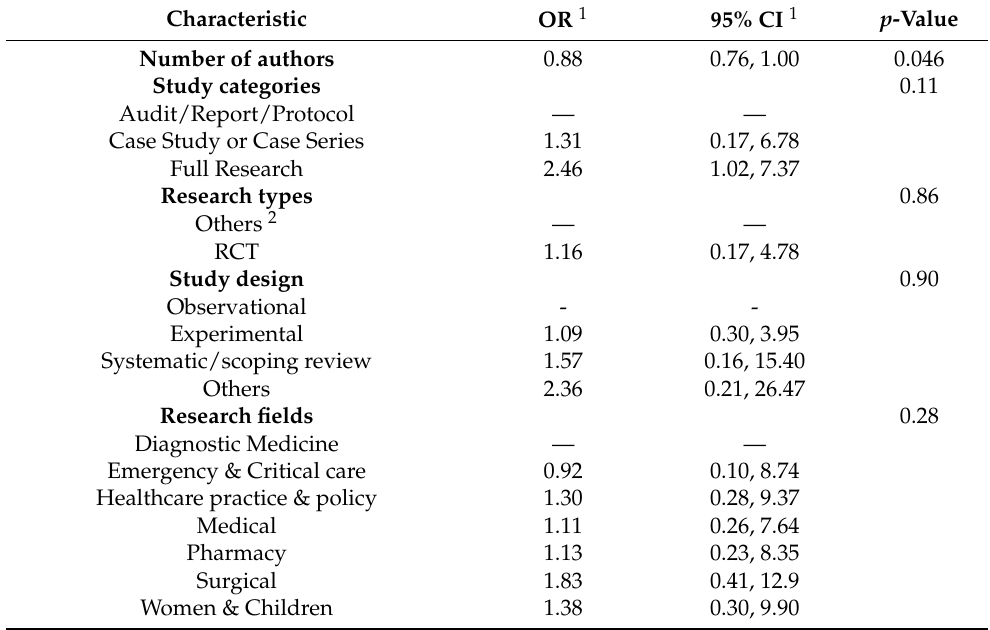
Table 3. Factors associated with publication based on univariate logistic regression